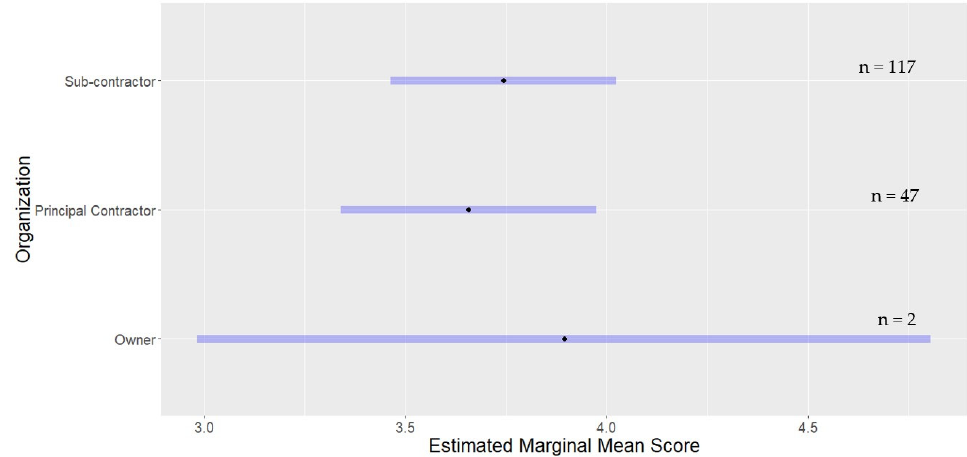
Figure 5. Estimated Marginal Means Distribution by Organization Safety Communication.